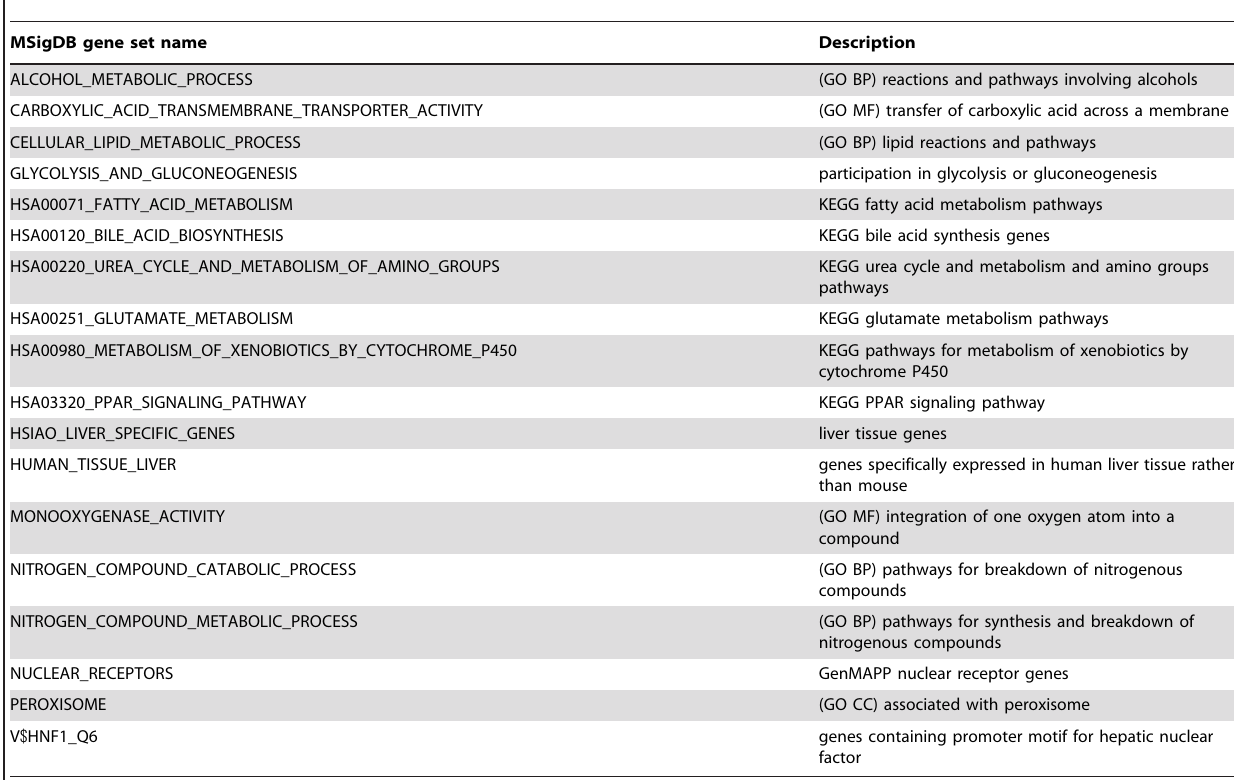
Table 2. Gene sets from MSigDB selected for our